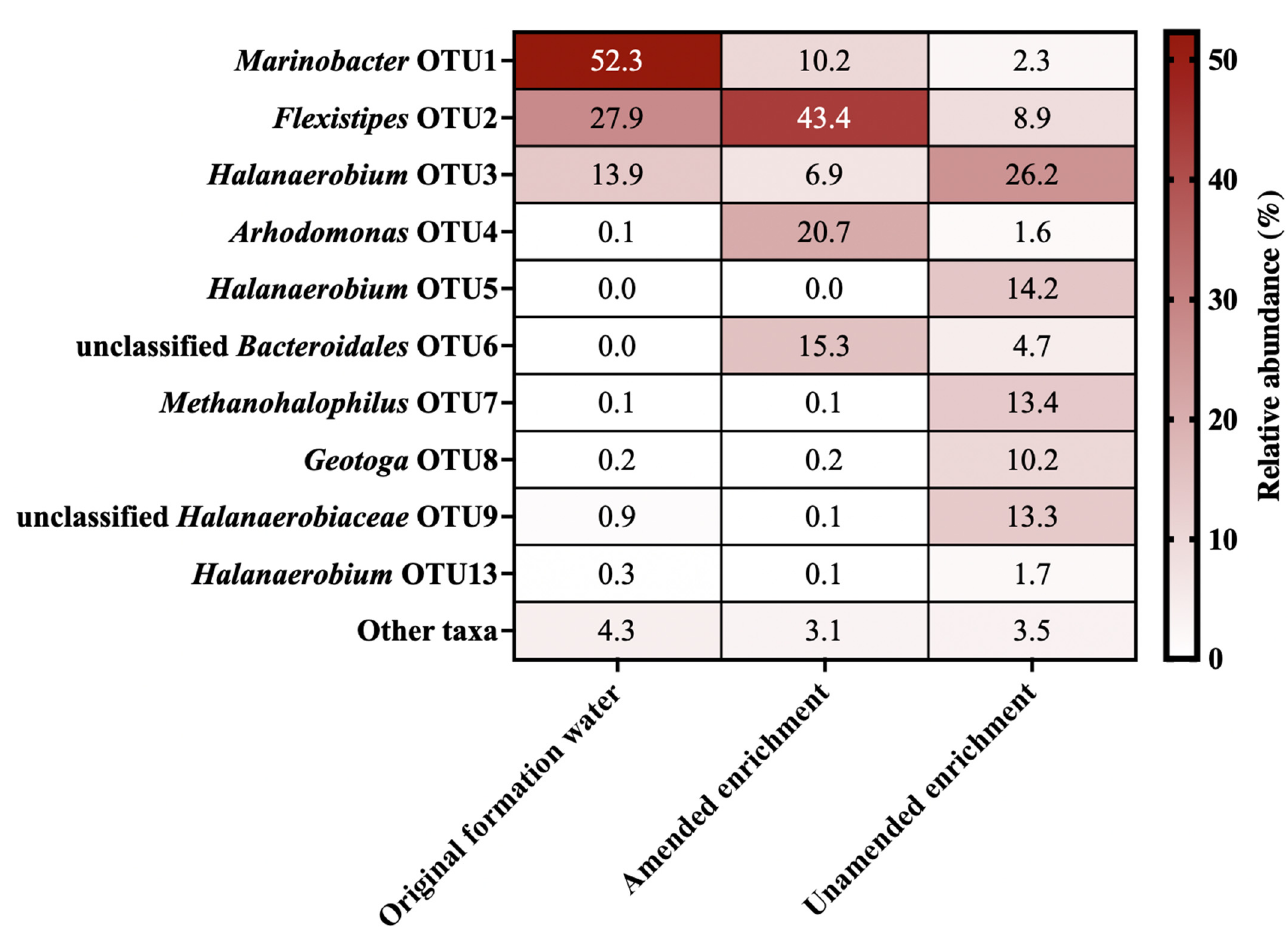
Figure 1. Microbial community composition in the original formation water and in amended and unamended enrichments incubated for 247 days. OTUs are defined by 97% sequence identity of 16S rRNA gene sequences. Community compositions are based on comparing 10,000 sequence reads per sample. OTUs with relative sequence abundances below 1% are grouped together as “Other taxa”. OTUs 6 and 9 have taxonomic assignments lower than 80% and could not be classified at the genus level.